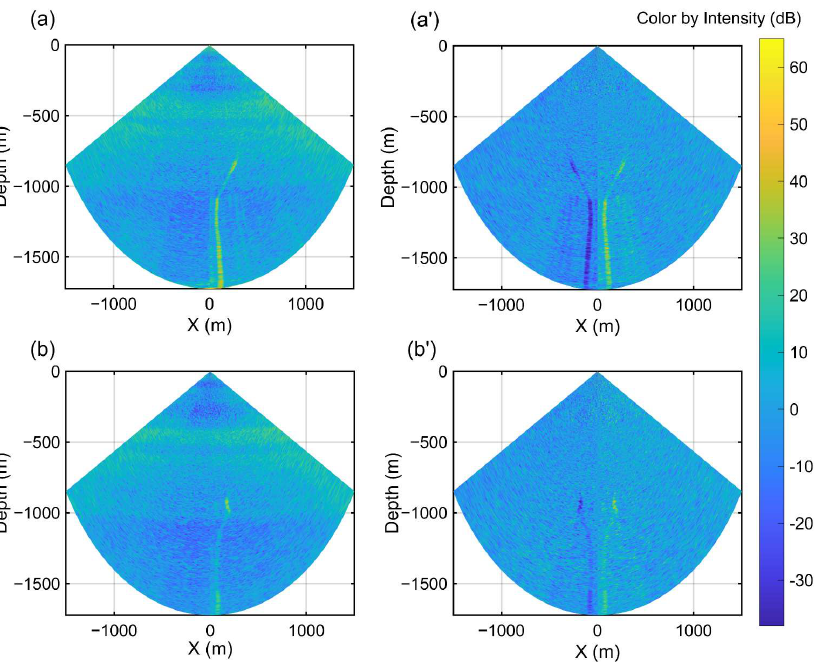
Figure 5. Comparison of symmetric subtraction results for single-ping MWC data. Figures ( a ) and ( b ) show the original single ping D-A spatial MWC images after the resolution of the MWC data, where the plume appears in the central beam position, and the noise in the upper part of the image is large and symmetrical, and the reflection intensity is similar to that of the plume, which is difficult to distinguish. ( a’ , b’ ) are the WCIs of the two pings after symmetric subtraction, showing that the noise in the upper part of the image is restored to normal, with the intensity of the plume reflection clearly distinguished from that of the background reflection.